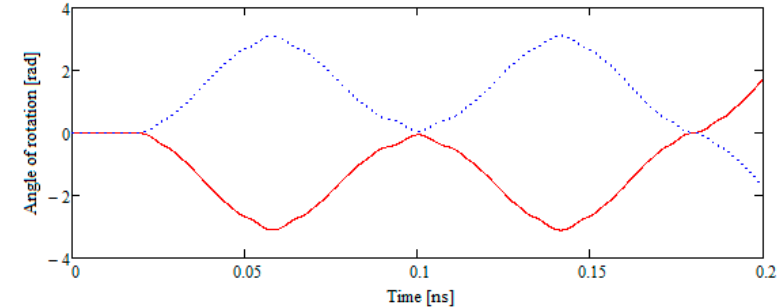
Figure 2. Rotation angles of two B 42 discs.